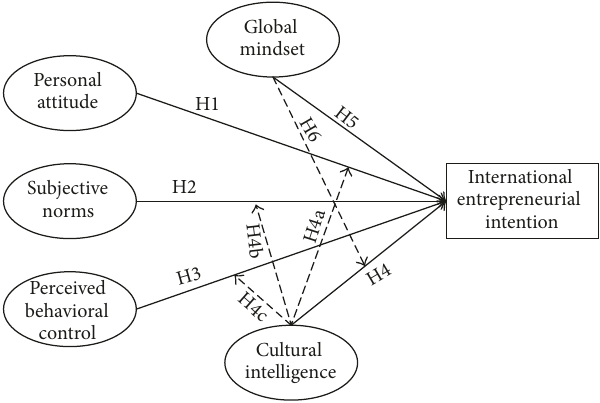
Figure 1: The conceptual model of this